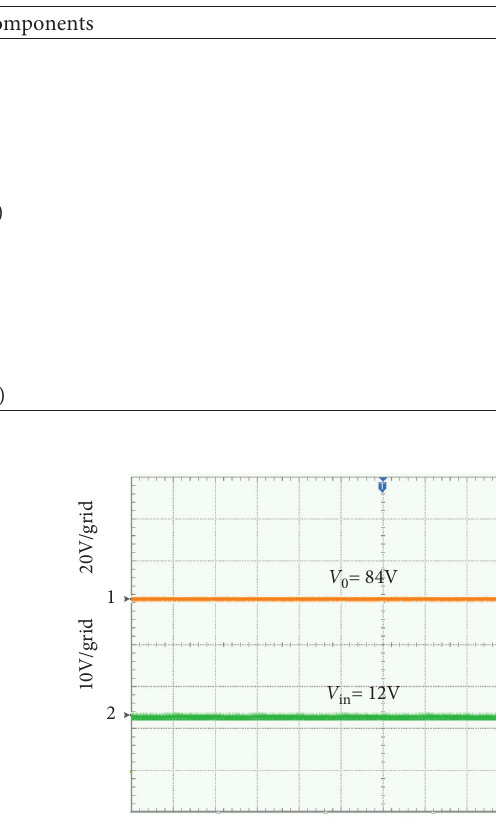
Table 5: Main circuit parameters.